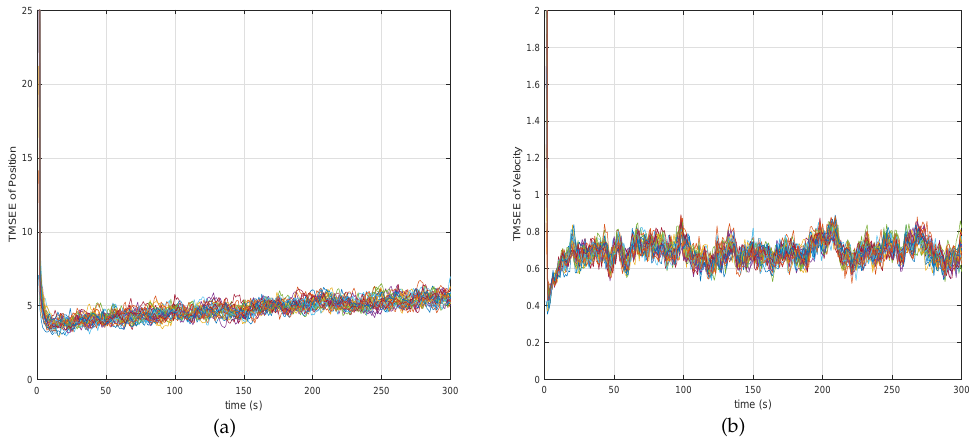
Figure 12. TMSEE of position and velocity of algorithm 2. ( a ) TMSEE of position; ( b ) TMSEE of